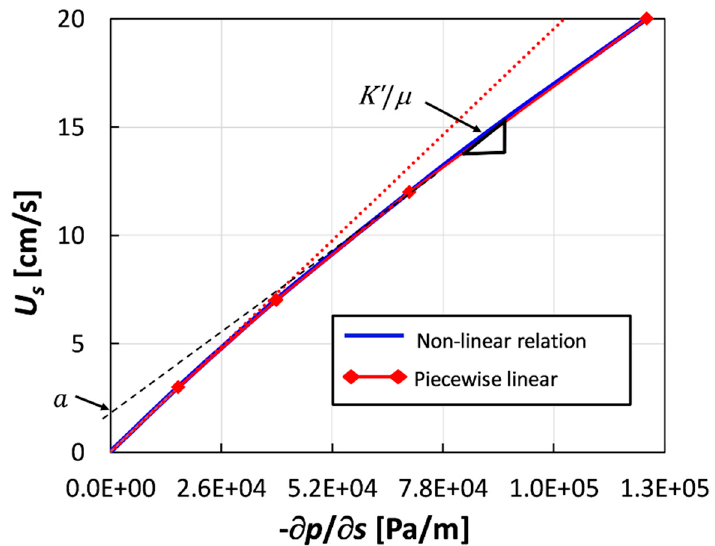
Figure 6. Dependence of the superficial velocity on the pressure gradient for the undeformed channel case (solid blue line), computed by 3-D CFD simulations [22]. The dotted red line represents the linear relation valid at low velocities. The straight red segments separated by symbols represent a piecewise linear fitting. As an example, the intercept, a , and the slope, K ’ / µ , of the fourth segment are indicated.